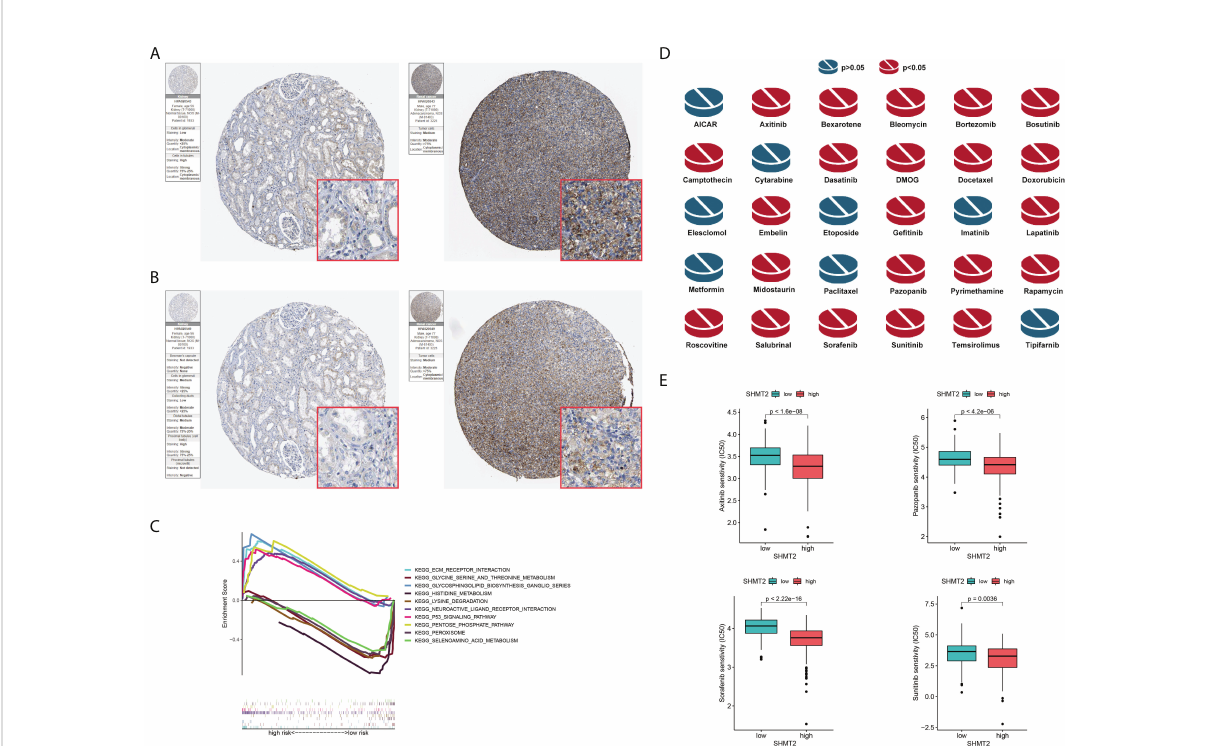
FIGURE 6 Validation of the role of SHMT2 at the translational level and in anti-tumour drugs. (A, B) Immunohistochemical images from the HPA database show SHMT2 protein expression in normal kidney (pictures on the right) and pRCC (pictures on the left) tissues by different antibodies. (C) GSEA analysis of KEGG in the high – and low – SHMT2 expression subgroups. Pathways such as the ECM receptor interaction pathway and p53 signalling pathway were upregulated in high – SHMT2 expression subgroups, which are recognised as the oncogenic pathways. (D) Estimated drug sensitivity in patients with high and low SHMT2 expression. The IC50s of 22 anti-tumour drugs were signi fi cantly different in the different SHMT2 expression groups. (E) The difference of anti-tumour drugs in IC50, including sunitinib (p = 0.0036), sorafenib (p < 2.22e-16), axitinib (p < 1.6e-08), and pazopanib (p < 4.2e-06) between the high – and low – SHMT2 expression subgroups. IC50, the half inhibitory concentration, and a P-value < 0.05 was considered statistically signi fi